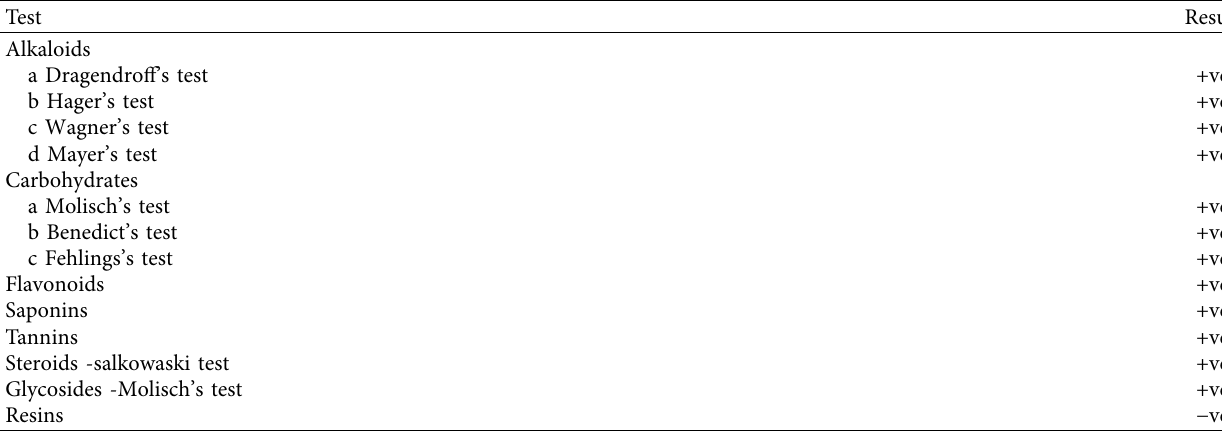
Table 4: Phytochemical analysis results.